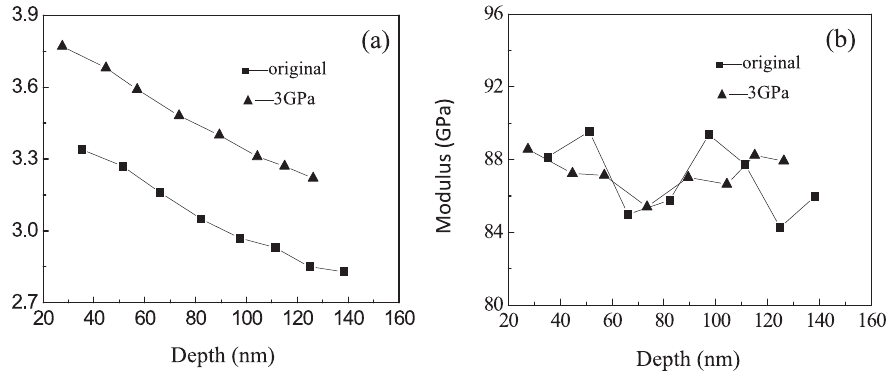
Fig. 6: Relationship between indentation depth and hardness, elastic modulus of the brass. (a) Hardness-depth curves; (b) modulus-depth curves